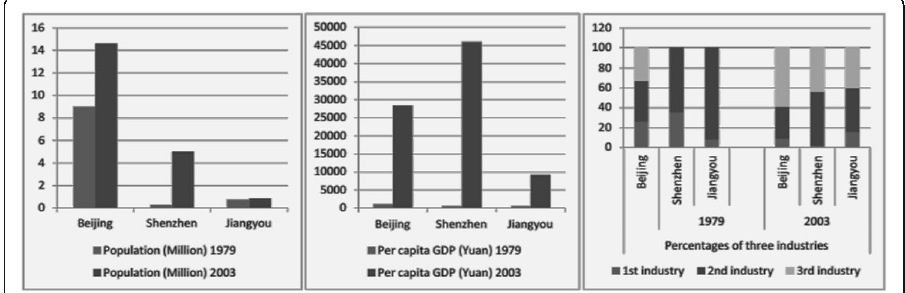
colour bar indicates the population of each city in 1979, while the dark colour bar indicates that of each city in 2003. The figure in the middle illustrates per capita GDP (in Chinese yuan ) in three cities. The light colour bar indicates per capita GDP of each city in 1979, while the dark colour bar indicates that of each city in 2003. The figure at right illustrates the composition of three industries in three cities in 1979 and 2003. From the bottom to the top of each bar, the dark grey section indicates agriculture, the even darker grey section indicates industry, and the light grey section indicates the service sector. (Statistics Bureau of Beijing,